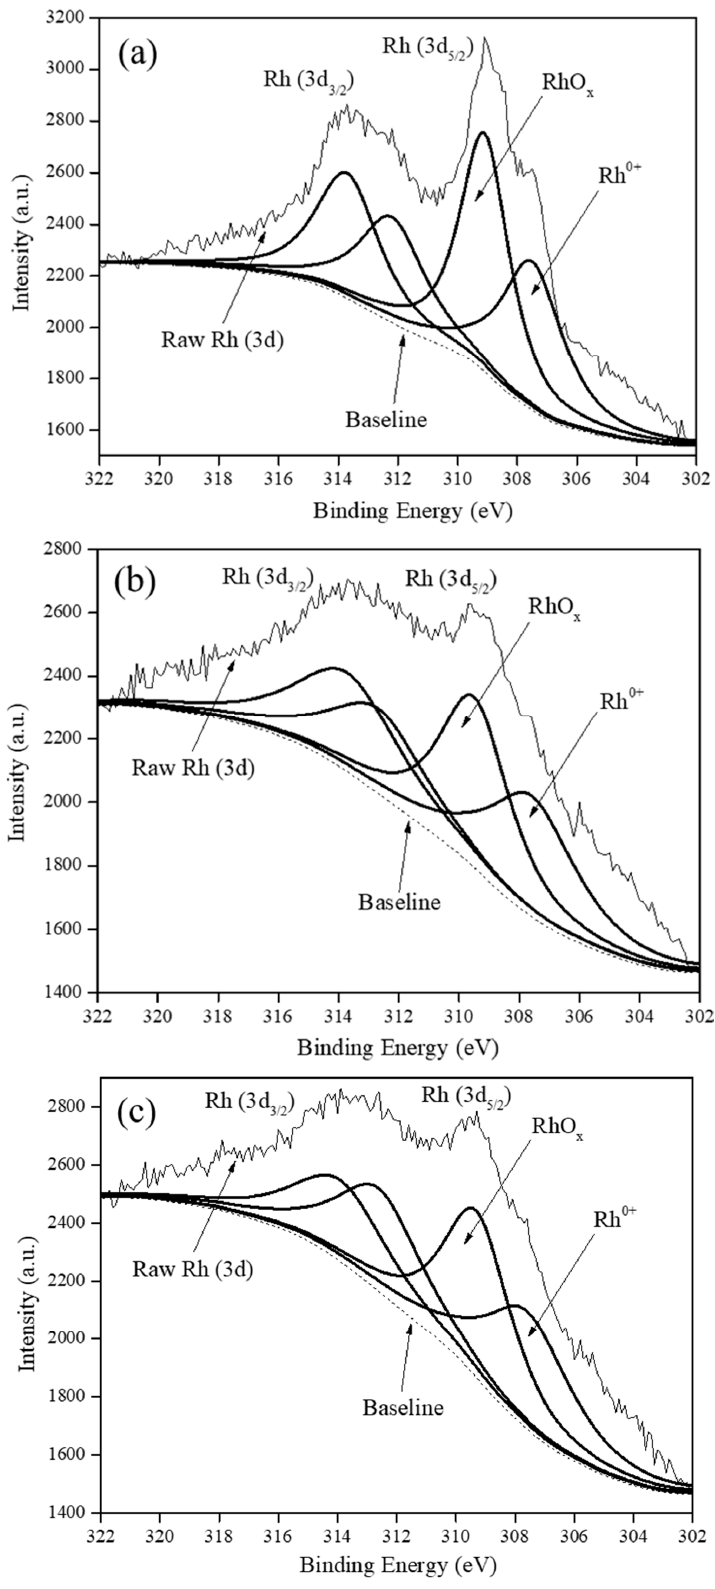
Figure3. XPS spectra of: ( a ) Rh 5 / VulcanXC72-polyol, ( b ) Rh 5 / Graphene-polyol and ( c ) Rh 5 / Figure 3. XPS spectra of: ( a ) Rh 5 /VulcanXC72-polyol, ( b ) Rh 5 /Graphene-polyol and ( c ) Rh 5 /MWCNTs- polyol.